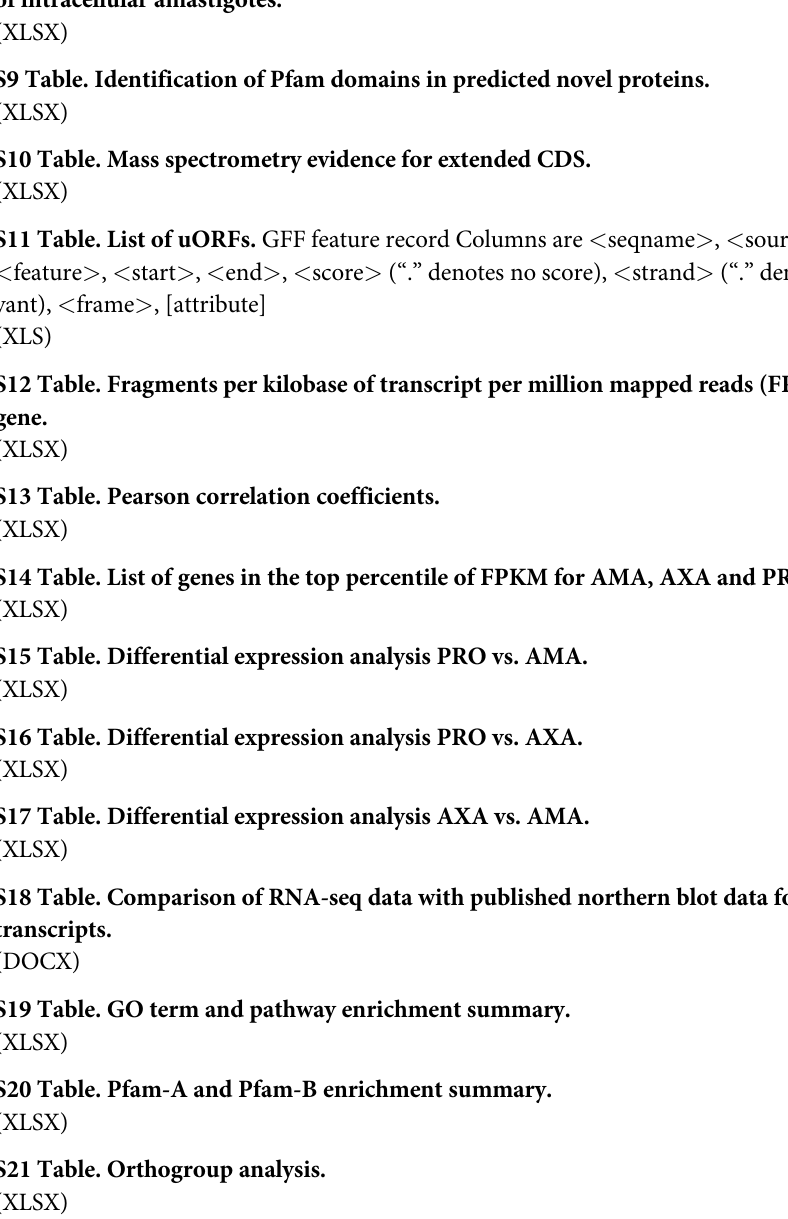
S6 Table. Reciprocal best tblastx analysis of conserved and novel genes. S7 Table. Mass-spectrometric evidence for novel proteins obtained from proteomic analysis of AXA and PRO. S8 Table. Mass-spectrometric evidence for novel proteins obtained from proteomic analysis of intracellular amastigotes. S9 Table. Identification of Pfam domains in predicted novel proteins. S10 Table. Mass spectrometry evidence for extended CDS. S11 Table. List of uORFs. GFF feature record Columns are < seqname > , < source > ,